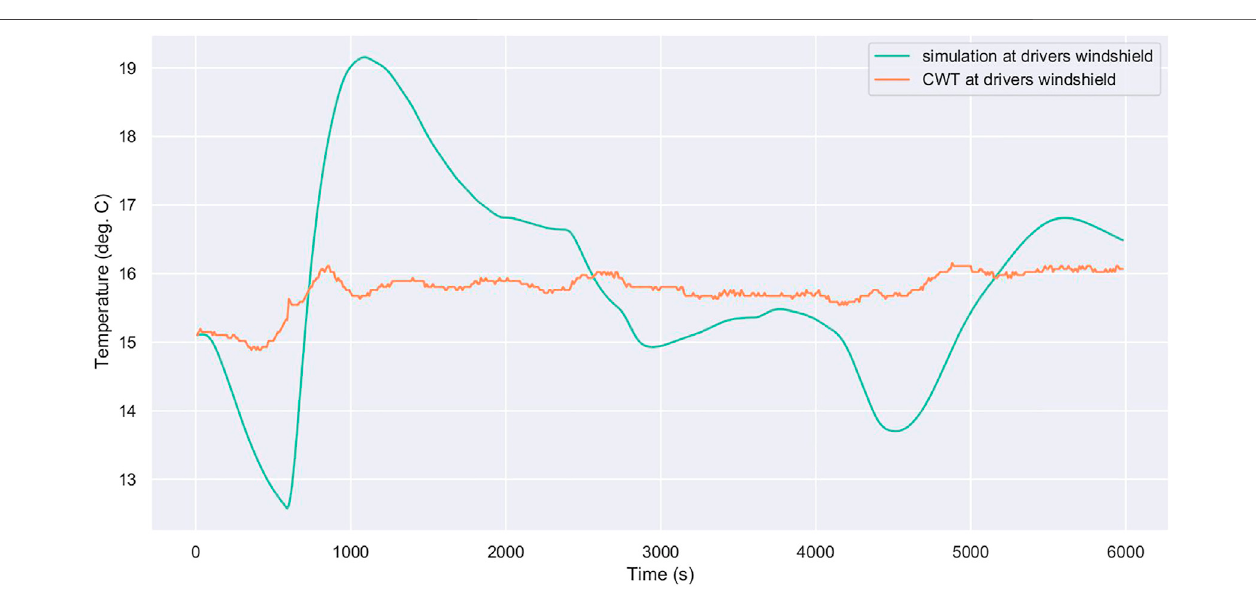
Frontiers in Mechanical Engineering |